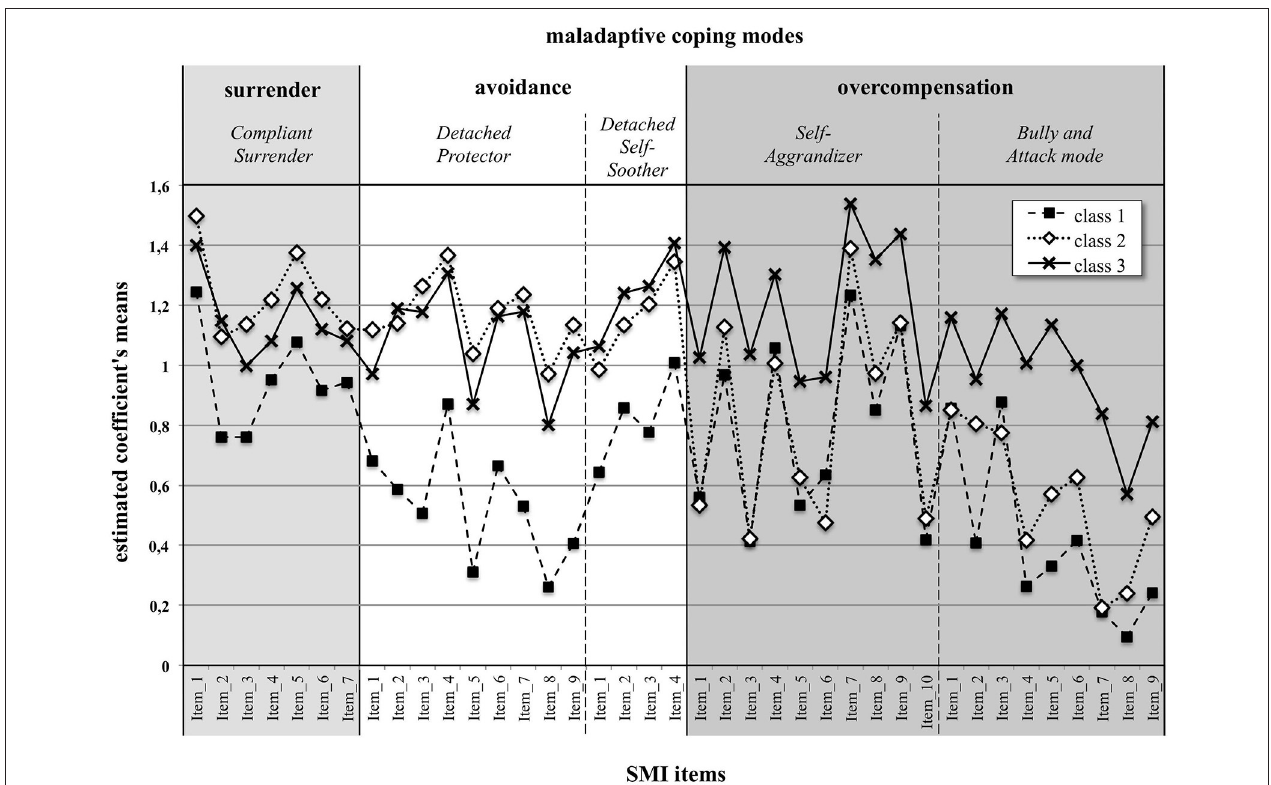
FIGURE 1 | Item response profiles of the three classes of PwMS in the five SMI maladaptive coping modes. The items belonging to the coping strategy of surrender are colored in light gray. The items belonging to avoidance (Detached Protector and Detached Self-Soother) are colored white. Colored in dark gray are those items belonging to overcompensation, i.e., the Self-Aggrandizer mode and the Bully and Attack mode. The estimated means were derived from the previous LPA.